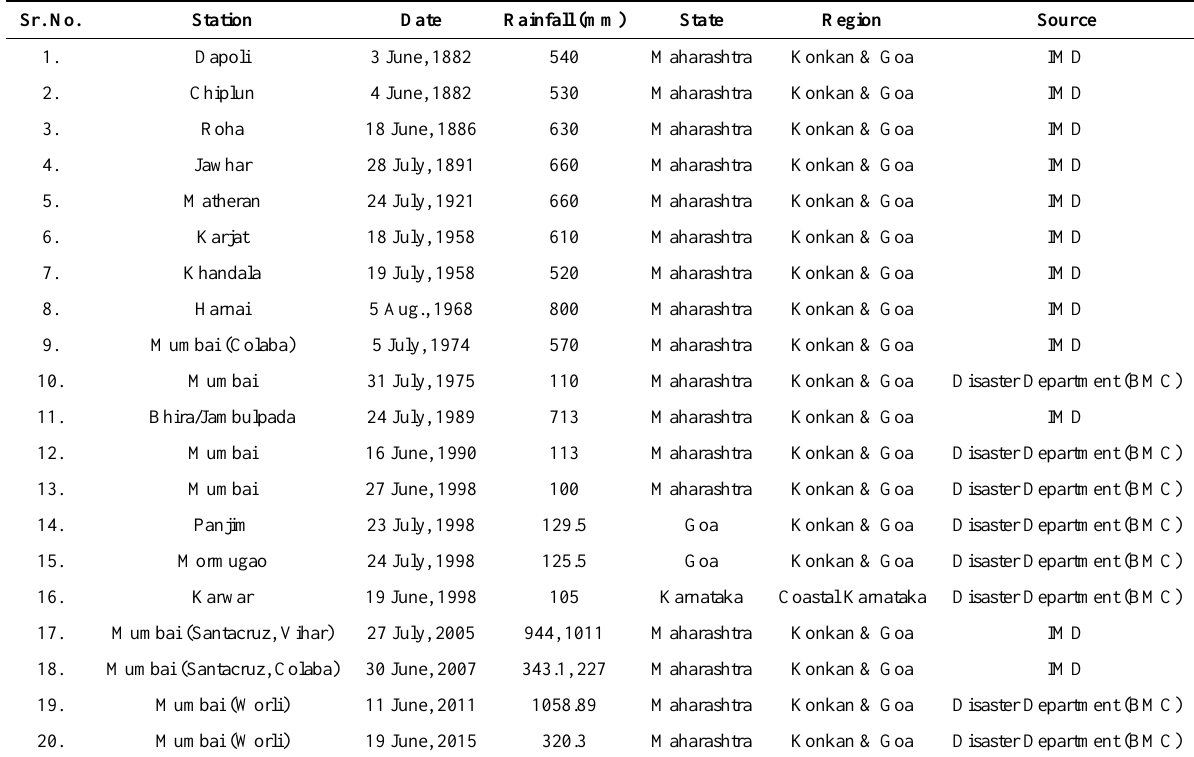
Figure 3. Average Annual Rainfall Table 2. List of Extreme rainfall events over the time